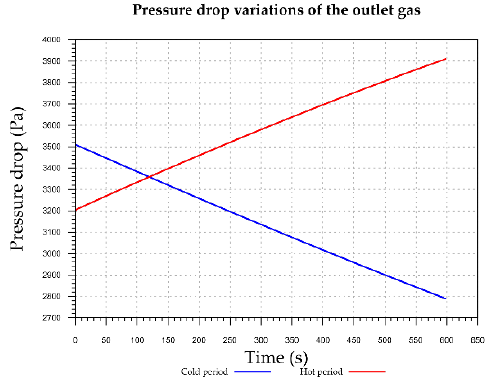
Figure 10. Dependences of pressure drop.